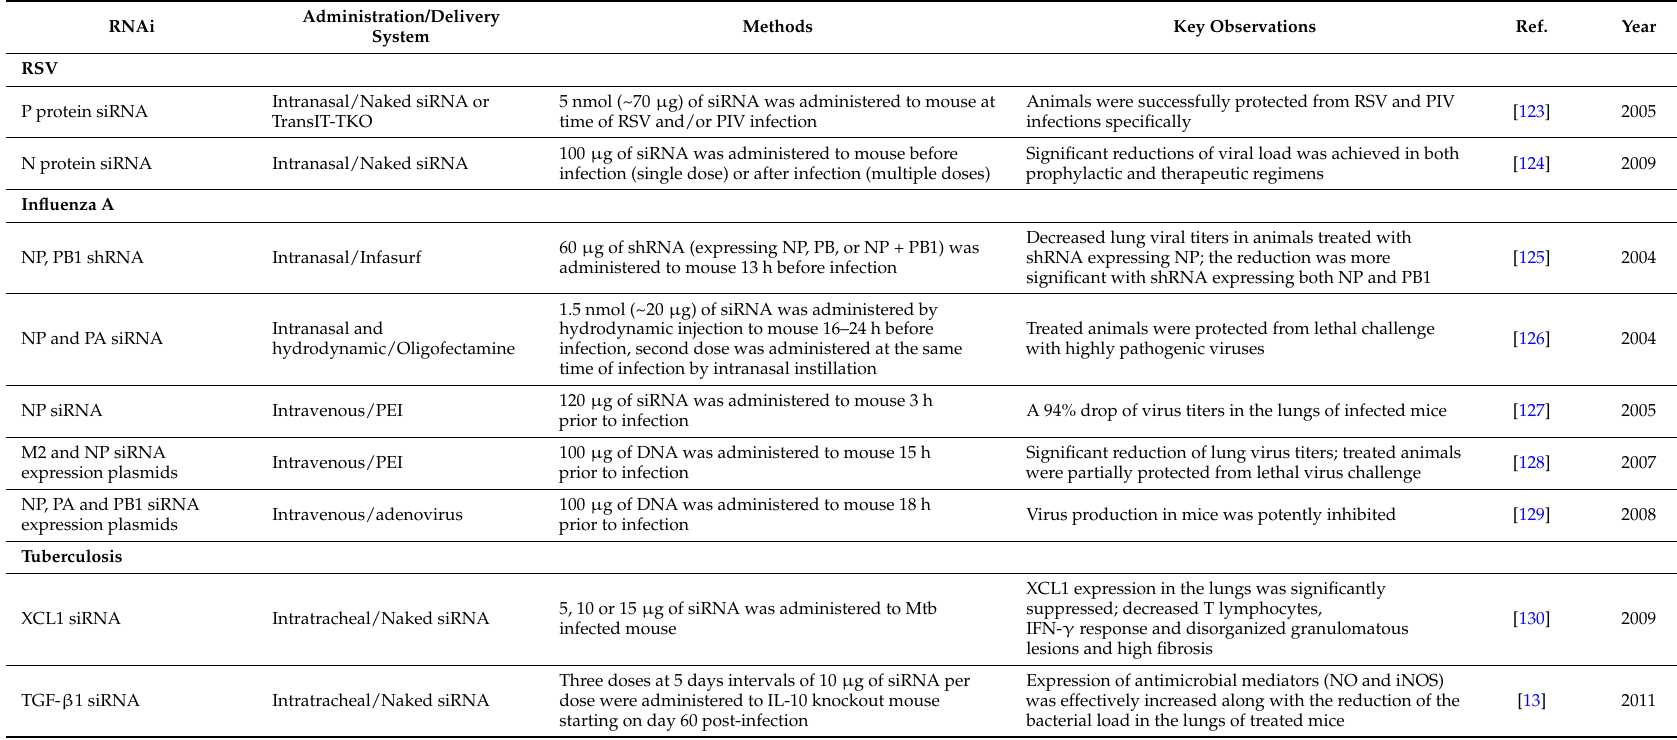
Table 3. Selected in vivo studies of using RNAi therapy on respiratory